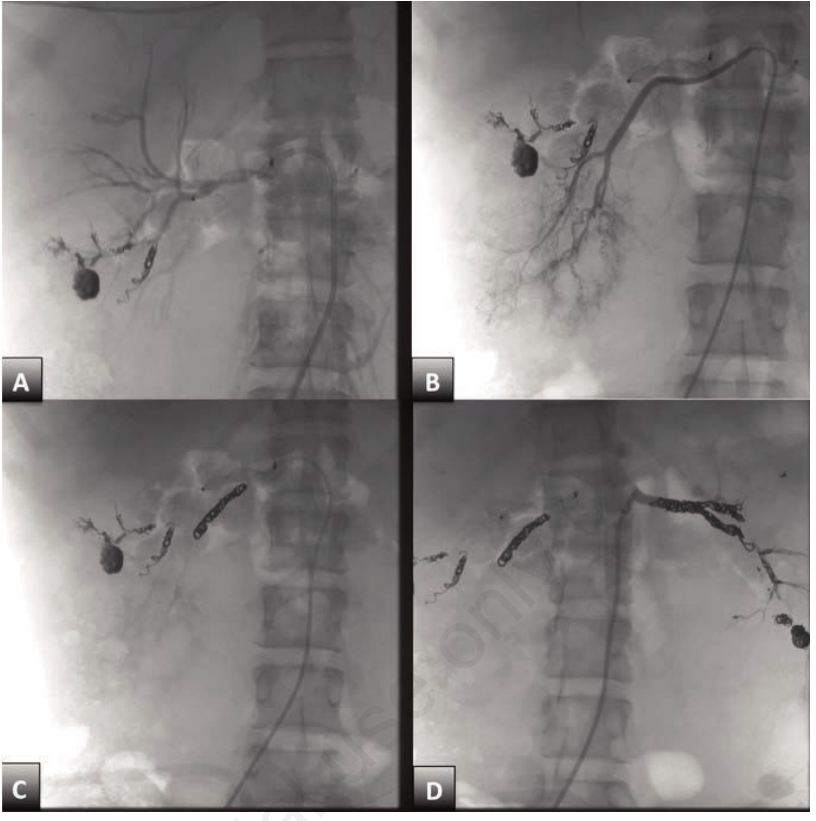
Figure 1. Bilateral renal artery embolization (AE). A: amplatzer-2 Plug 8 mm tran- scatheter release in the juxta-ostial tract of the right renal artery; B: selective catheteriza- tion of the lower right renal artery; C: selective embolization of the lower right renal artery; D: selective left renal AE embolization and its lobar branches by transcatheter release of metal spirals.